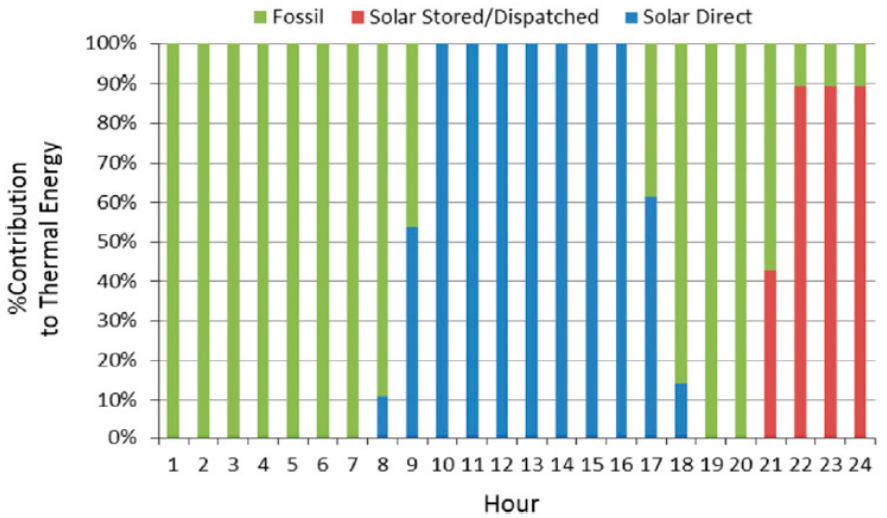
Figure 3. Hourly contribution of the thermal energy resources during January [29].